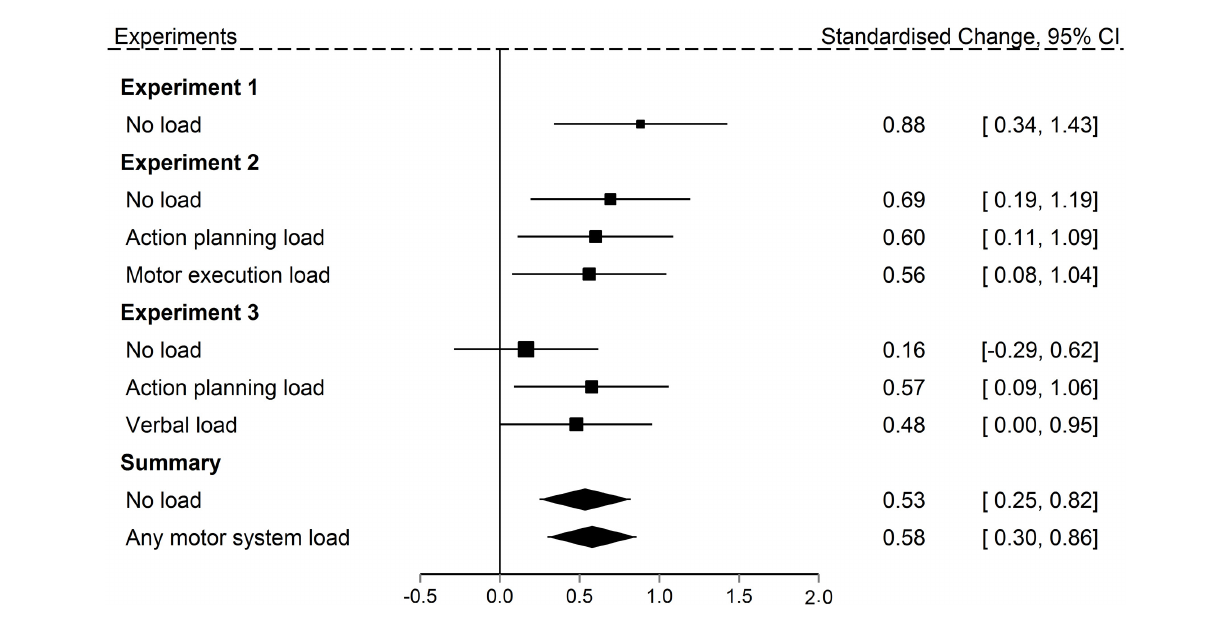
Frontiers in Psychology |